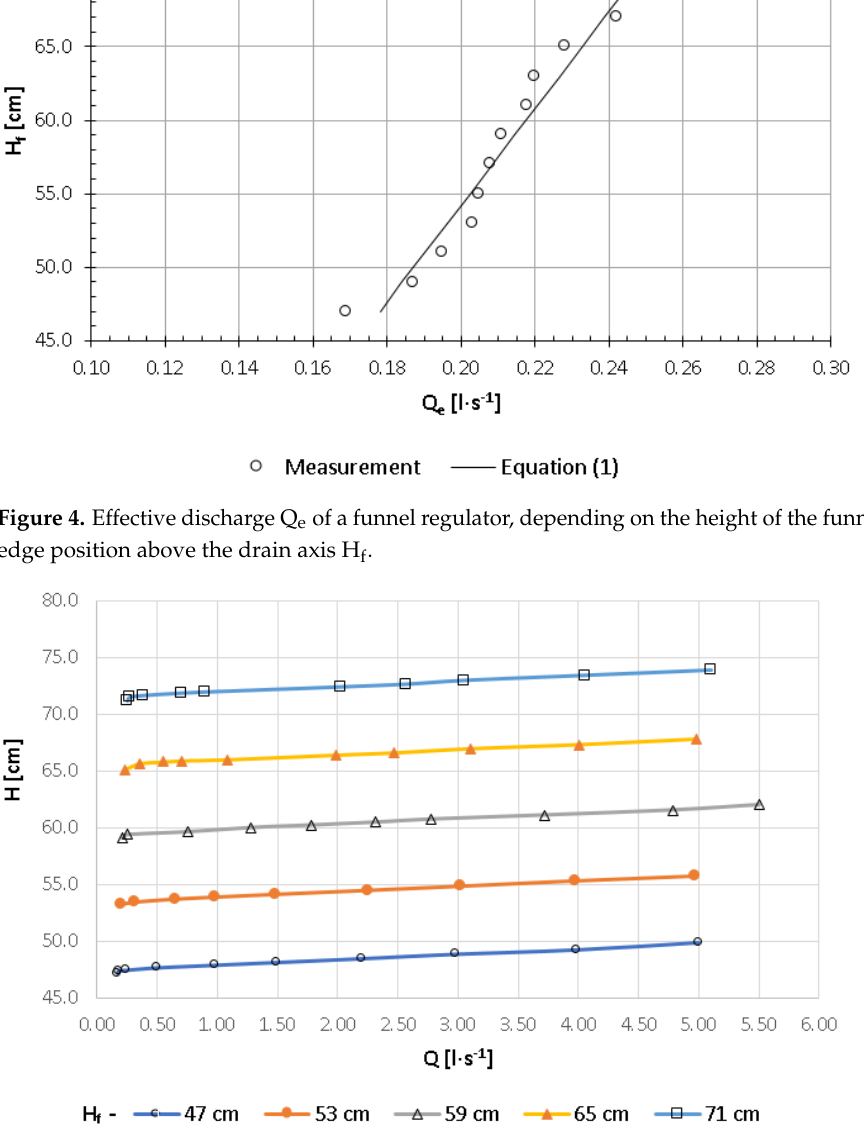
Figure 5. Curves of the overflow discharge Q of the funnel regulator at different heights of the water level in relation to the drain axis H.